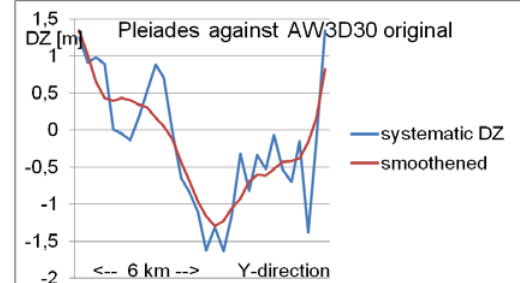
Fig. 16. Systematic height errors in Y-direction, Zonguldak,